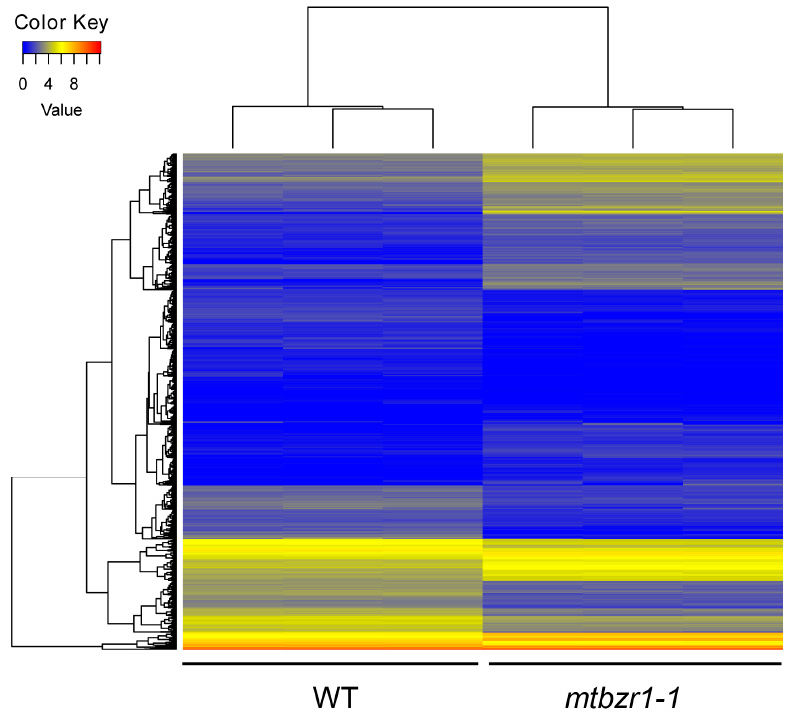
Figure 5. The heatmap of FPKM (fragments per kilobase of transcript per million reads mapped) values of 1,319 differential expressed genes in three biological replicates of nodules from mtbzr1-1 and wild-type plants.